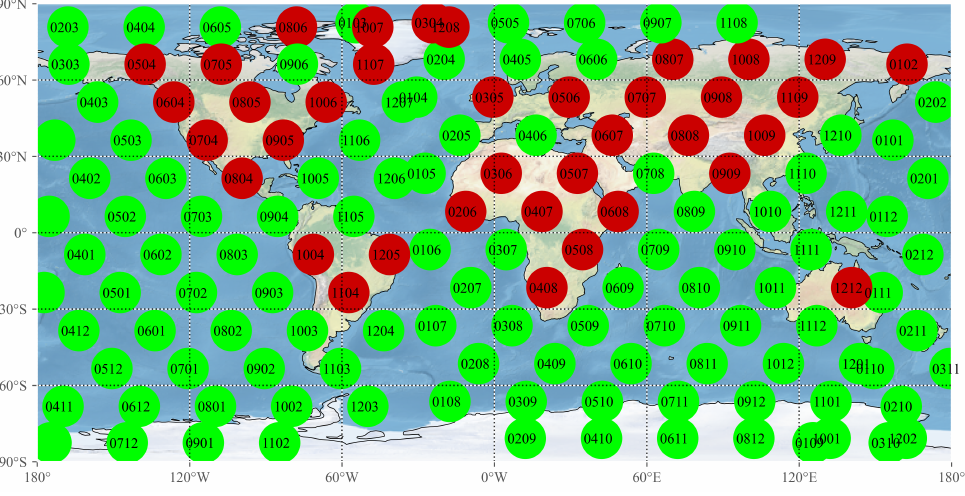
Figure 6. Constellation 2 snapshot.